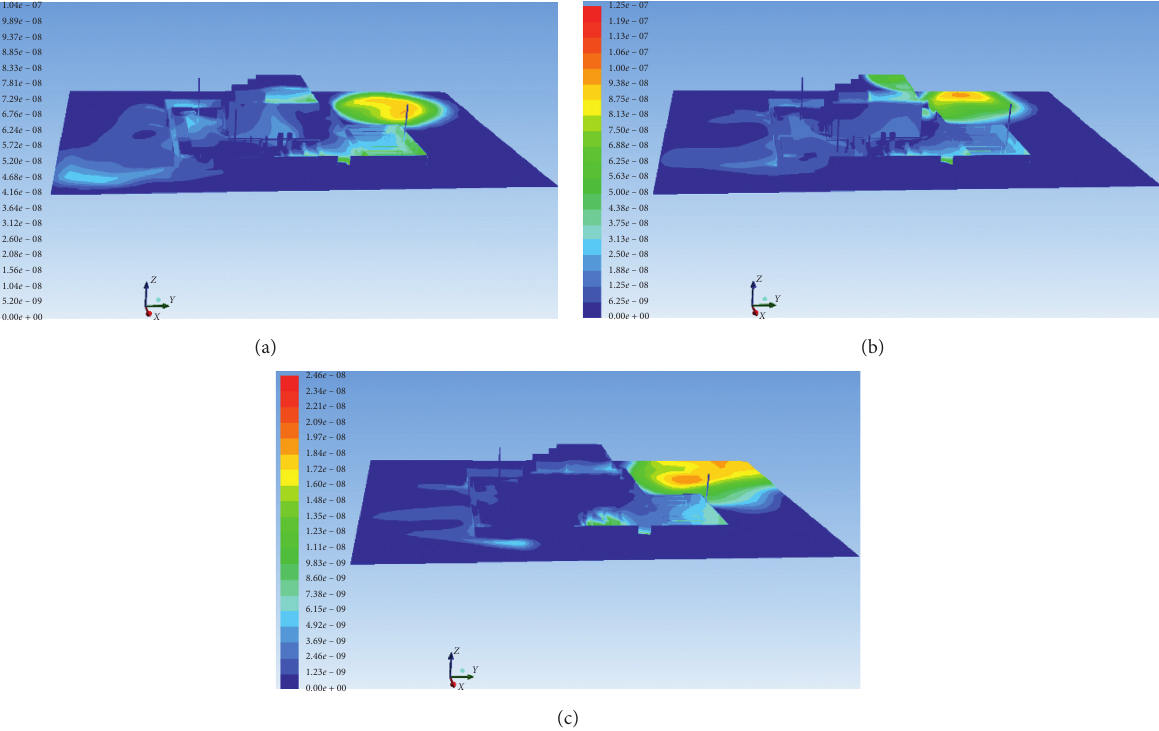
Figure 13: Simulation results of concentration-field ( t � 180s). (a) u � 2m/s. (b) u � 5m/s. (c) u � 10m/s.